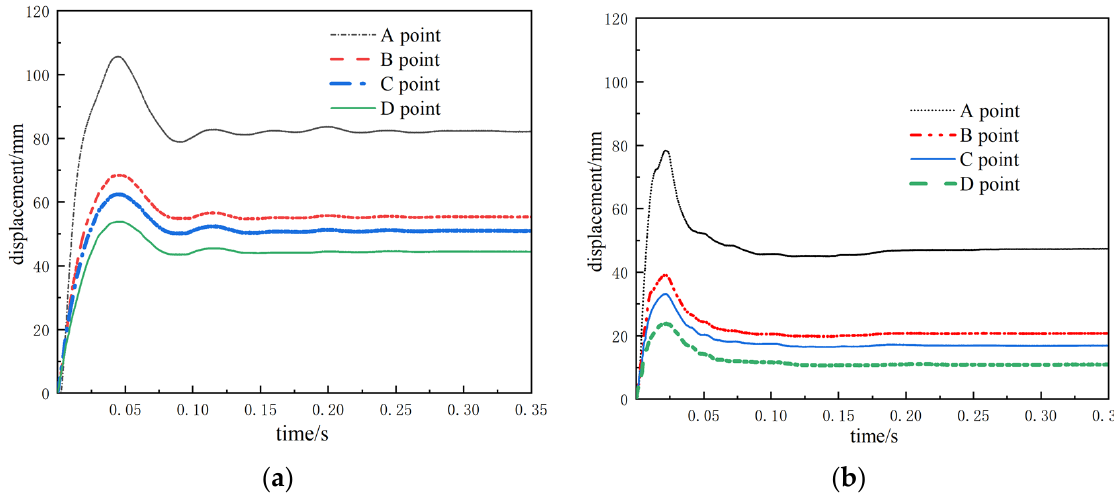
Figure 9. Displacement-time history curve. ( a ) RC column. ( b ) SM-RC column.